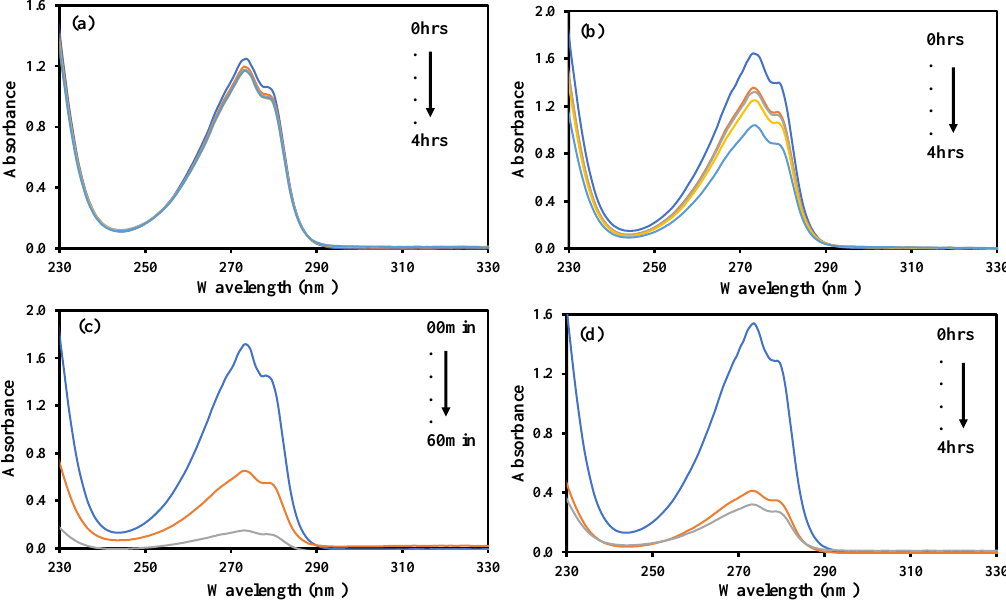
Figure 7. Rate of resorcinol degradation at pH values of ( a ) 2, ( b ) 4, ( c ) 7, ( d ) 9.